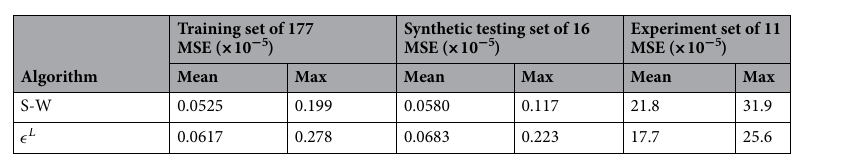
Figure 4. ( a ) An example profile (dislocation density of 8.47 that has been processed to isolate variations in peak shape. ( b ) The profiles shown on a log scale highlight the shape of the tails of the peaks.